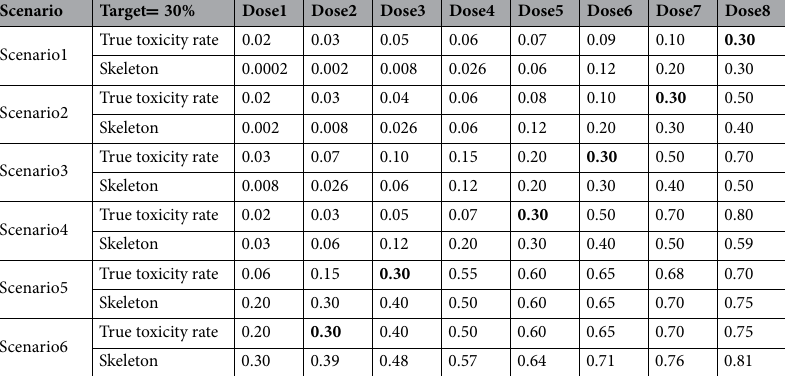
Table 1. Six Scenarios with different MTDs. True toxicity rate at MTDs are in